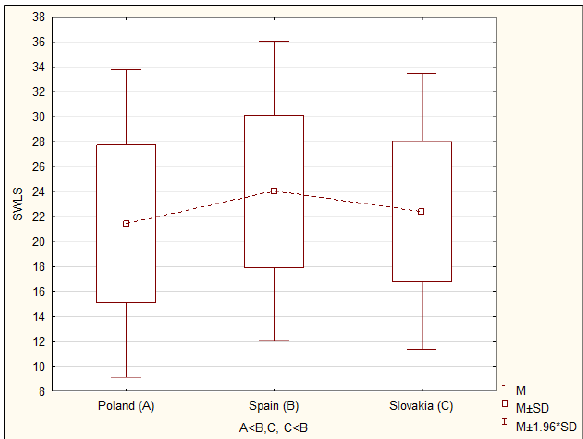
Figure 2. Comparison of average results of life satisfaction according to SWLS among Polish, Spanish and Slovak students.